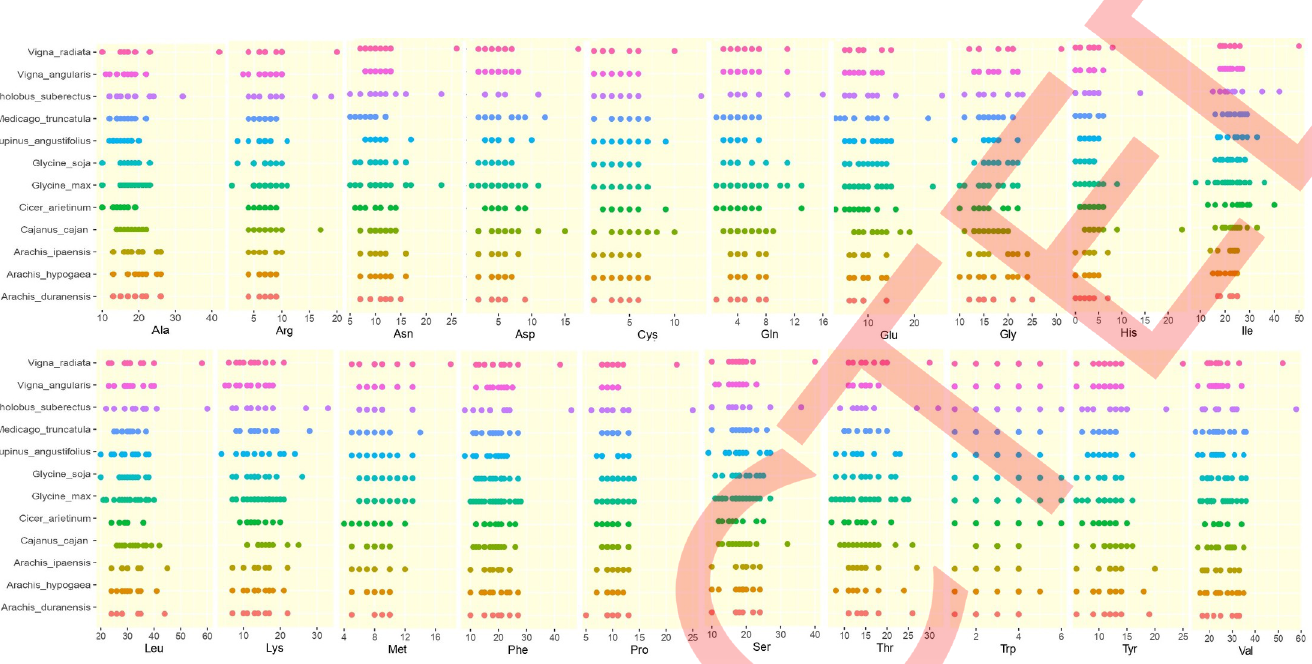
Fig 2. Showing amino acid composition of SWEET proteins across 12 Fabaceae species. Each color represents a different SWEET protein among 12 species. The plot has frequency of amino acids on X-axis and different species on Y-axis. https://doi.org/10.1371/journal.pone.0268154.g002 5.04 found in Glycine max , and the highest pI value was 9.82 in Cajanus Cajan . The pI value above seven indicates the zero net electrical charge at the basic value of pH. Negatively charged residues (Asp + Glu) range from (7–37), and positively charged residues (Arg + Lys) range from (12–49) (Fig 3, S1 Table). It helps in predicting the topology of proteins [35].